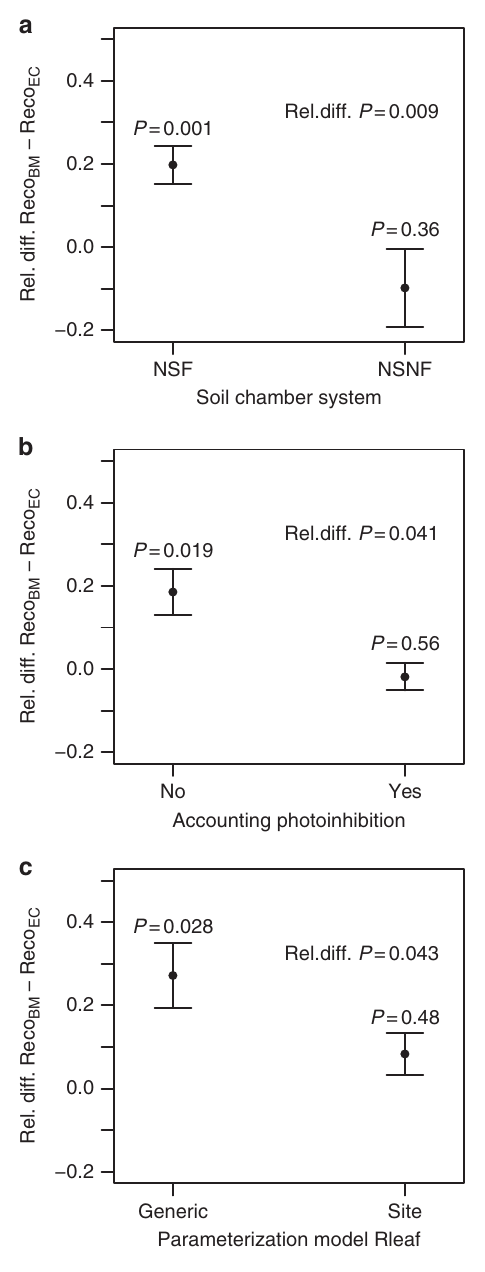
Figure 3 | Impact of variants of biometric methods on the difference between ecosystem respiration from biometric methods and eddy-covariance. The relative difference between ecosystem respiration from biometric methods (Reco BM ) and eddy-covariance (Reco EC ) [(Reco BM (cid:2) Reco EC )/((Reco EC þ Reco BM )/2)] when ( a ) using different chamber systems to measure soil respiration (NSF: non-steady-state through-flow chamber; NSNF: non-steady-state non-through-flow chambers), ( b ) whether light inhibition is accounted for when estimating leaf respiration (Rleaf), and ( c ) employing generic or site-specific parameterization for the empirical models used to scale up the point measurements of Rleaf to the annual scale. Points indicate means and bars the standard error of the mean. The P value above each point indicates the significance level of the difference between Reco BM and Reco EC for each case, whereas the significance level P of each factor (that is, chamber system, accounting light inhibition, parameterization type) is indicated as rel. diff. P (relative difference between Reco BM and Reco EC ) and is reported in the top right of each